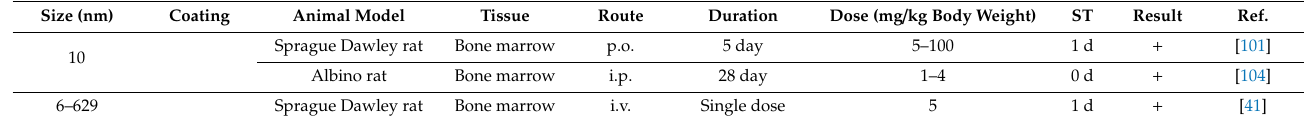
Table 5. In vivo chromosome aberration assay results.